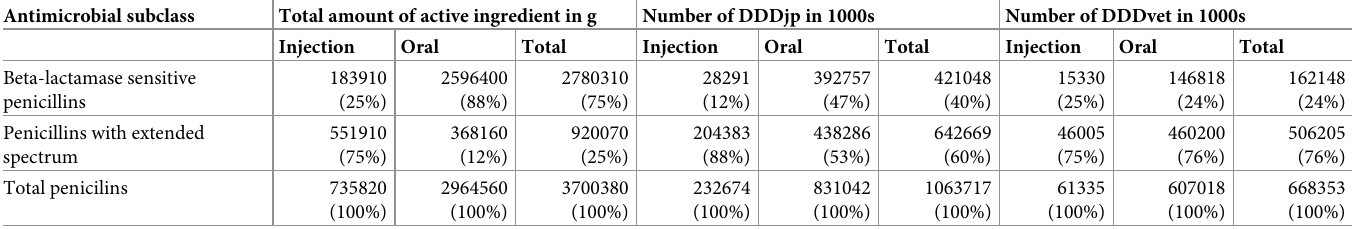
Table 4. Total penicillin use on the 74 pig farms measured as active ingredient and by Japanese and European DDD grouped by different subclasses (beta-lactamase sensitive penicillins and penicillins with extended spectrum). Antimicrobial subclass